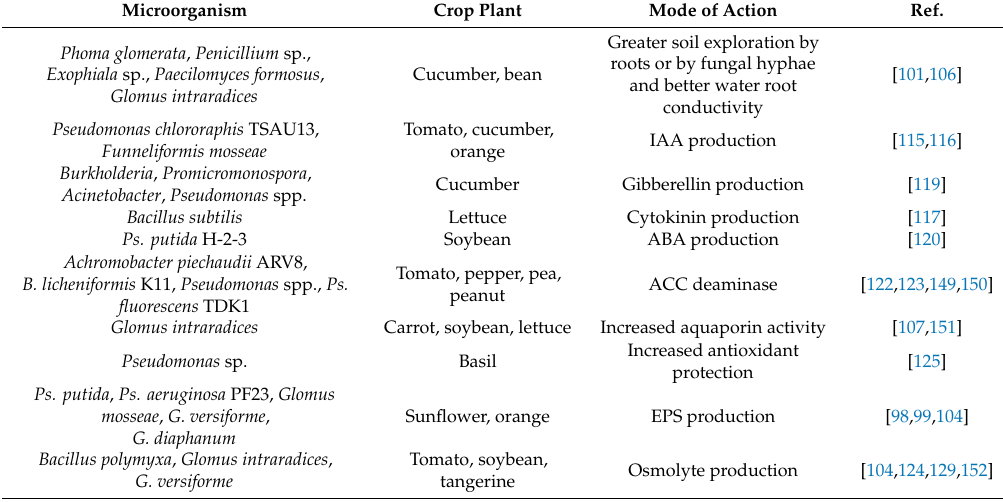
Table 2. Microorganisms active against water